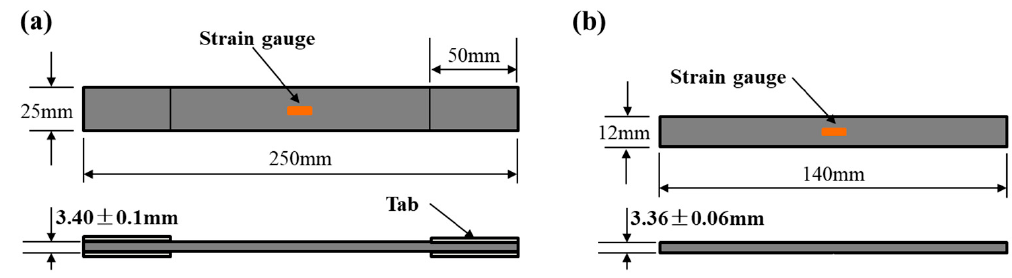
Figure 5. Sketch with the dimension for ( a ) tensile and ( b ) compressive specimens.